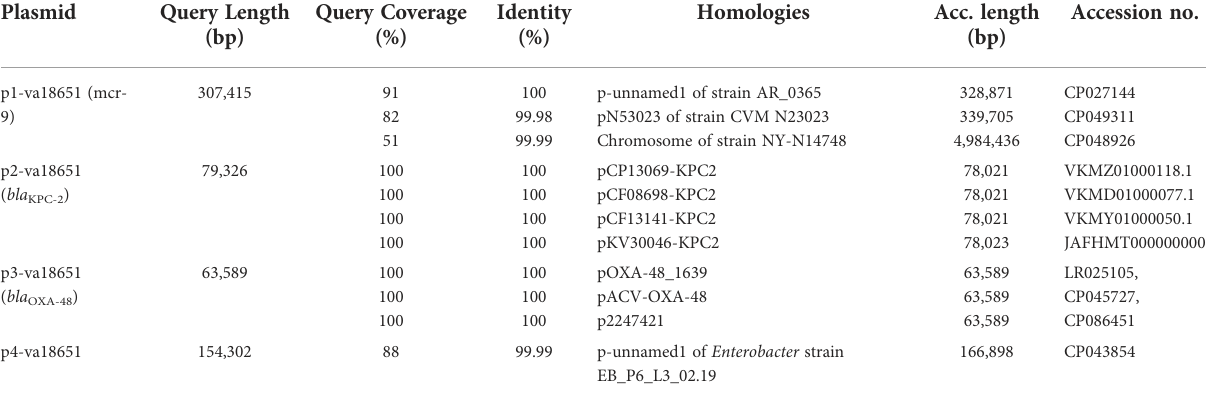
TABLE 3 Examples of sequences highly related to the plasmids of Enterobacter xiangfangensis va18651.